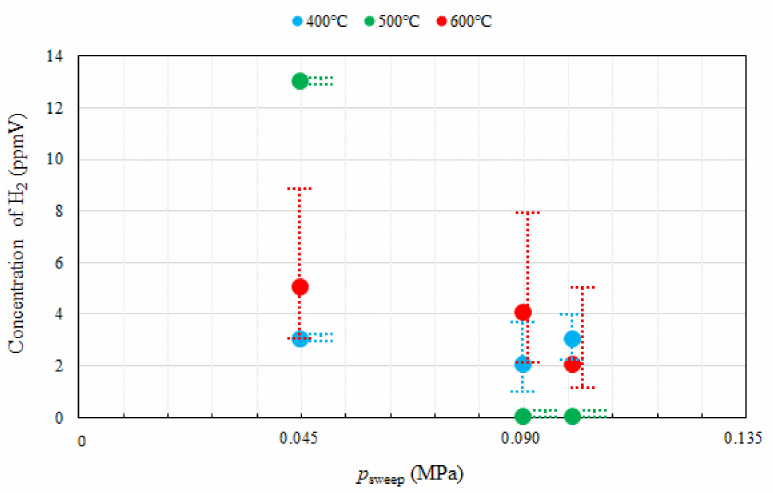
Figure 9. Impact of concentration of H 2 at the outlet of sweep chamber with p sweep and reaction temperature.